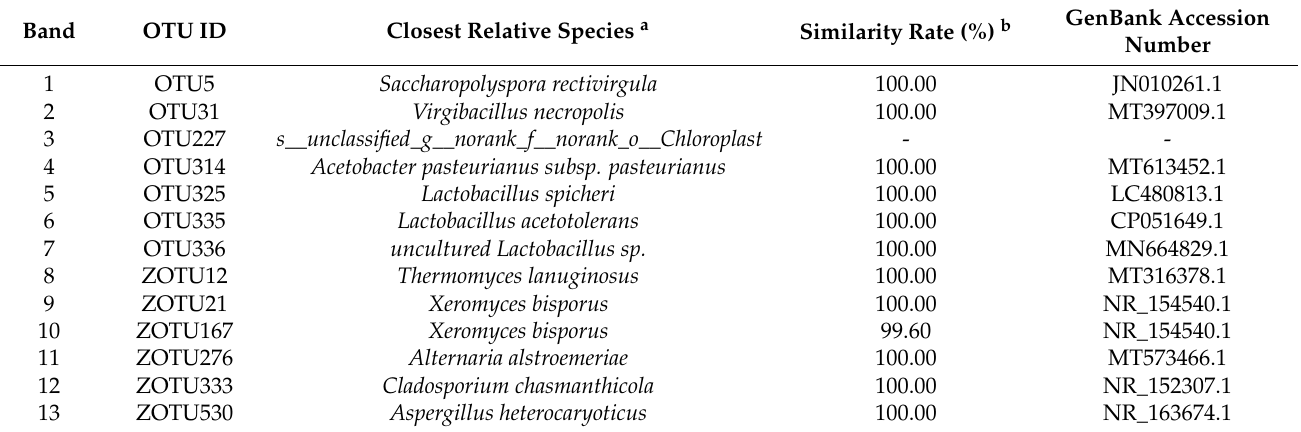
Table 3. Dominant OTUs during fermentation with taxonomic annotation against NCBI